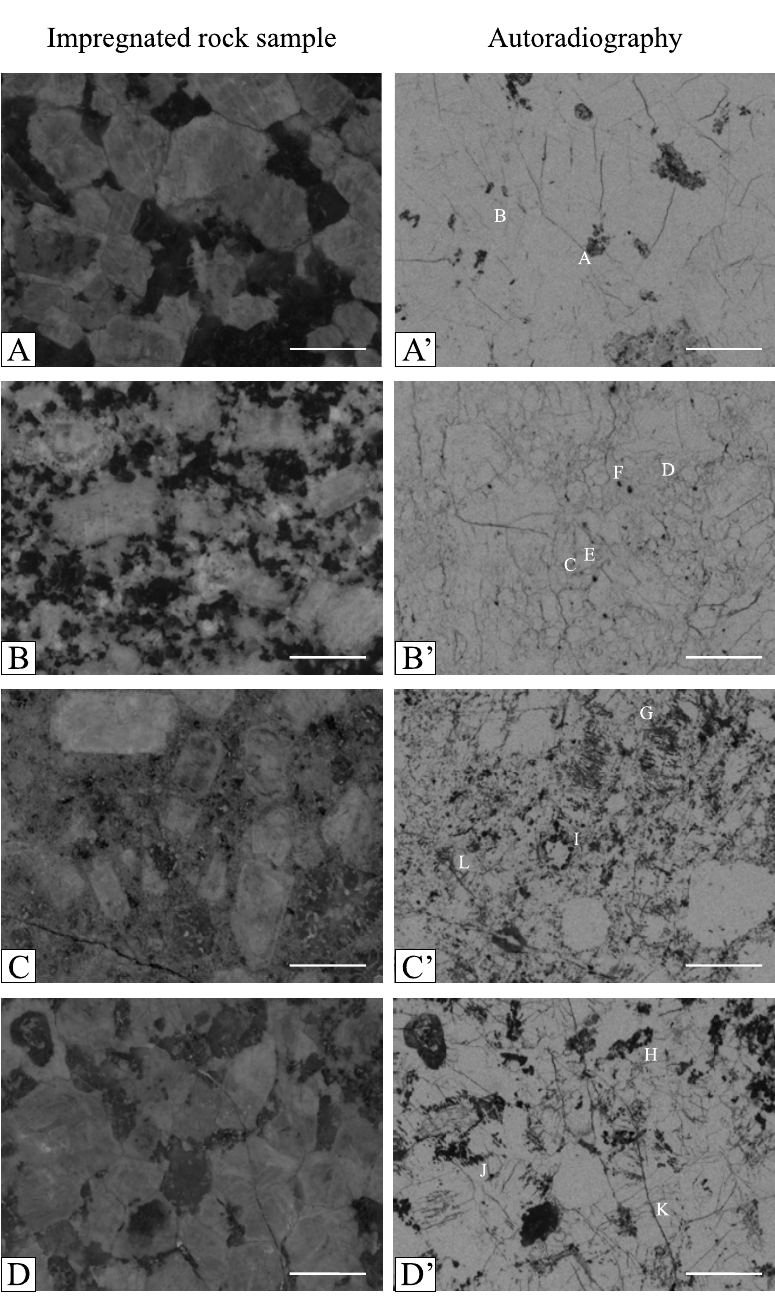
Fig. 2 – Sawed sections of 14 C-PMMA impregnated rock samples (left, A-D) and its corresponding autoradiographies (right, A’-D’). Area of each sample is 4.4 cm 2 and scale bars are 0.5 cm length. Samples A and B represents unaltered rocks from western border (equigranular perthite granite)andcentral(porphyriticmonzogranite)graniticfaciesrespectively. SamplesCandDrepresentspropylitic-alteredporphyriticsyenogranite (C) and equigranular perthite granite (D) from a continuous core sample from eastern border granitic facies. Autoradiographs permit to observe the spatial distribution and micrometer to decimeter heterogeneities of porous zones between different rocks. Black areas are associated to high porosity level (see text for discussion). White letters on the autoradiography (A to L) correspond to sites showed in Figure 3.